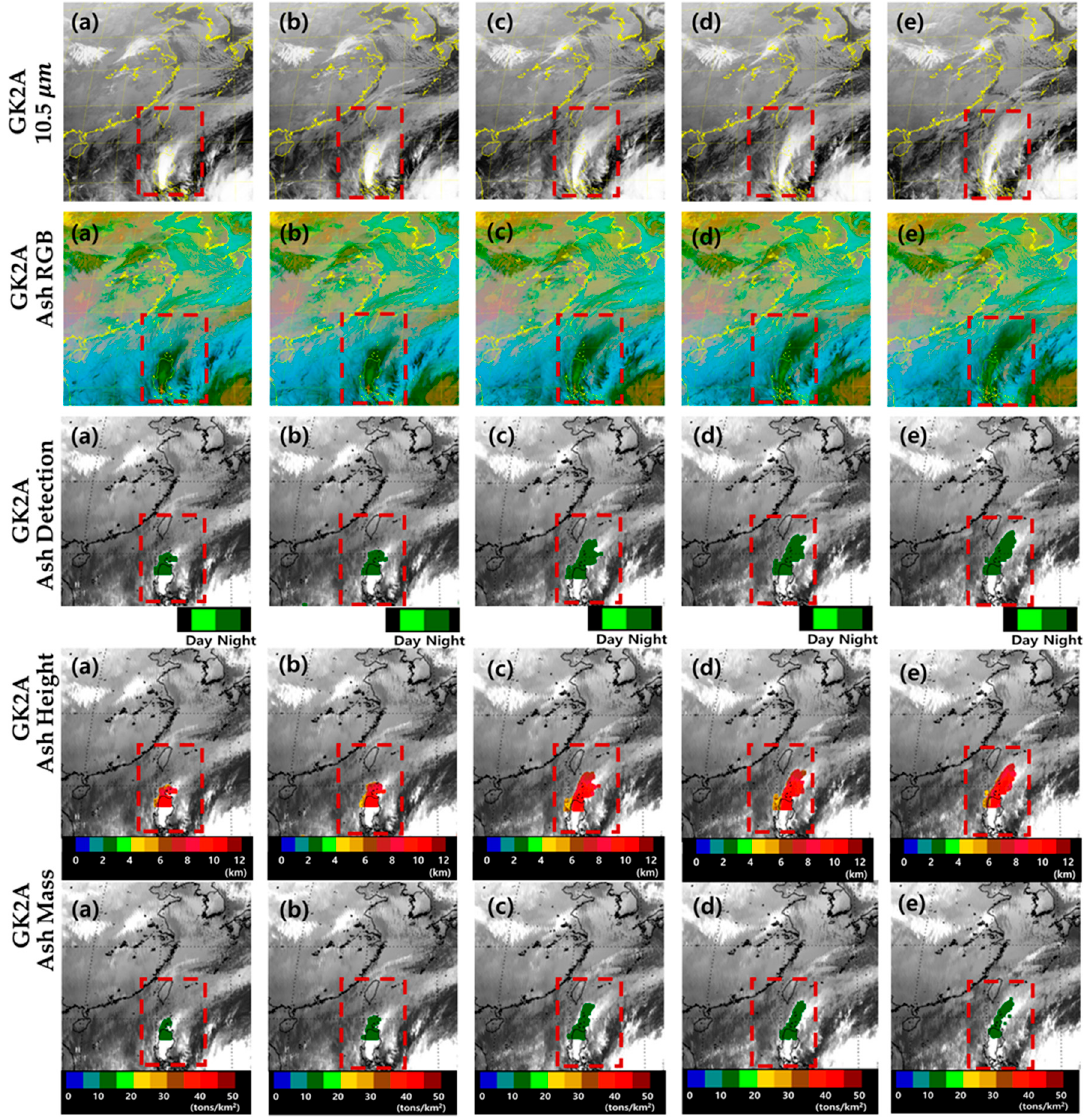
Figure 6. Images of the Taal volcano eruption (red dashed box) based on GK-2A BT 10.5 µ m, GK-2A Ash RGB, GK-2A volcanic ash detection (VAD), GK-2A volcanic ash height (VAH), and GK-2A volcanic ash mass (VAM) on 12 January 2020 ( a ) 14:00, ( b ) 15:00, ( c ) 16:00, ( d ) 17:00, and ( e ) 18:00 UTC. The image boundary is a rectangular region (latitude 12 ◦ N–37 ◦ N and longitude 105 ◦ E–132 ◦ E; Philippines Expansion Area).